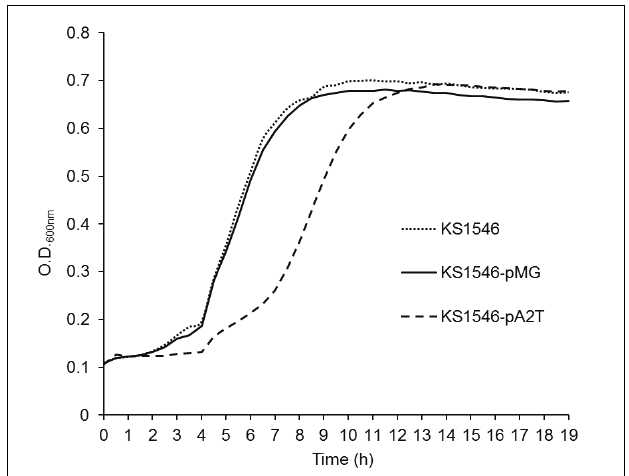
FIGURE 3 | Temporal growth profile of the recombinant producer (KS1546-pA2T), and the native producer with empty plasmid (KS1546-pMG) or without plasmid ( L. garvieae KS1546). Data were acquired from triplicate assays. Standard deviations are within a range ± 0.01 to ± 0.05.